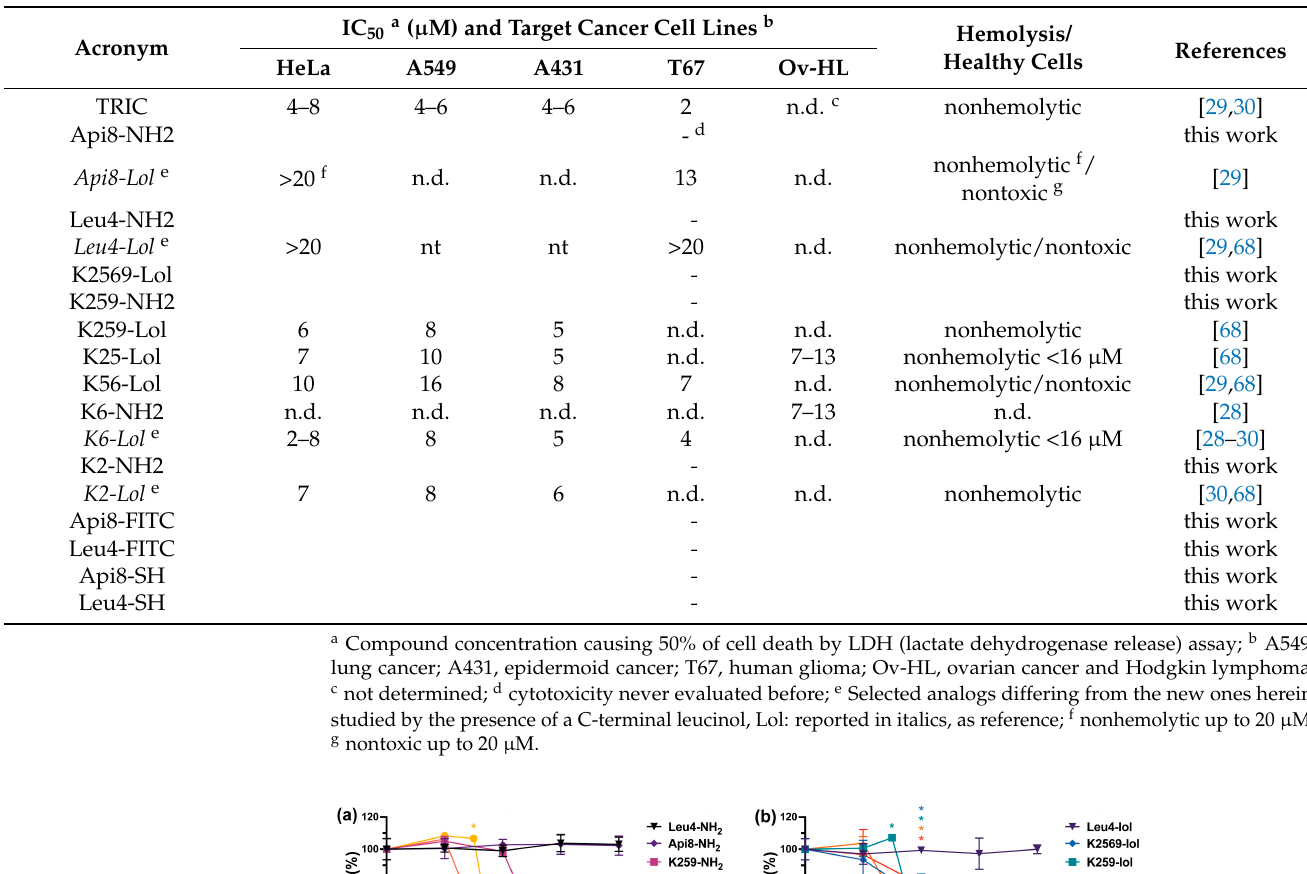
Table 2. Overview of the cytotoxic activity reported in the literature for some of the phytopharma- ceutical peptides herein studied, together with selected analogs thereof as reference compounds.